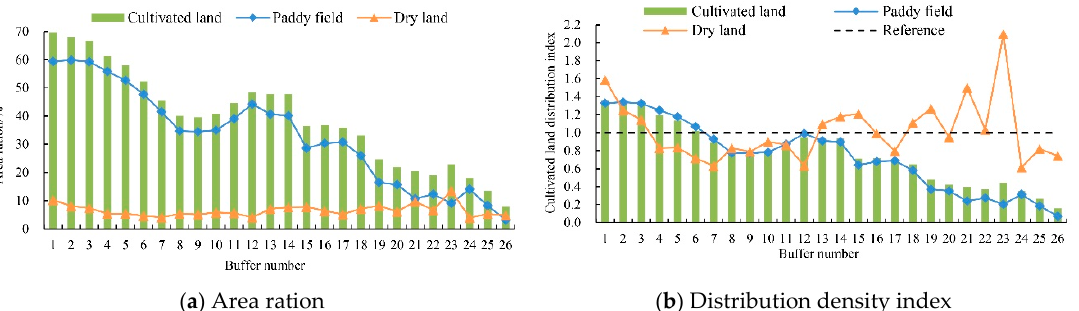
Figure 5. Distribution of cultivated land buffer zone. ( a ) proportion of cultivated land area to buffer area; ( b ) change of distribution density index.